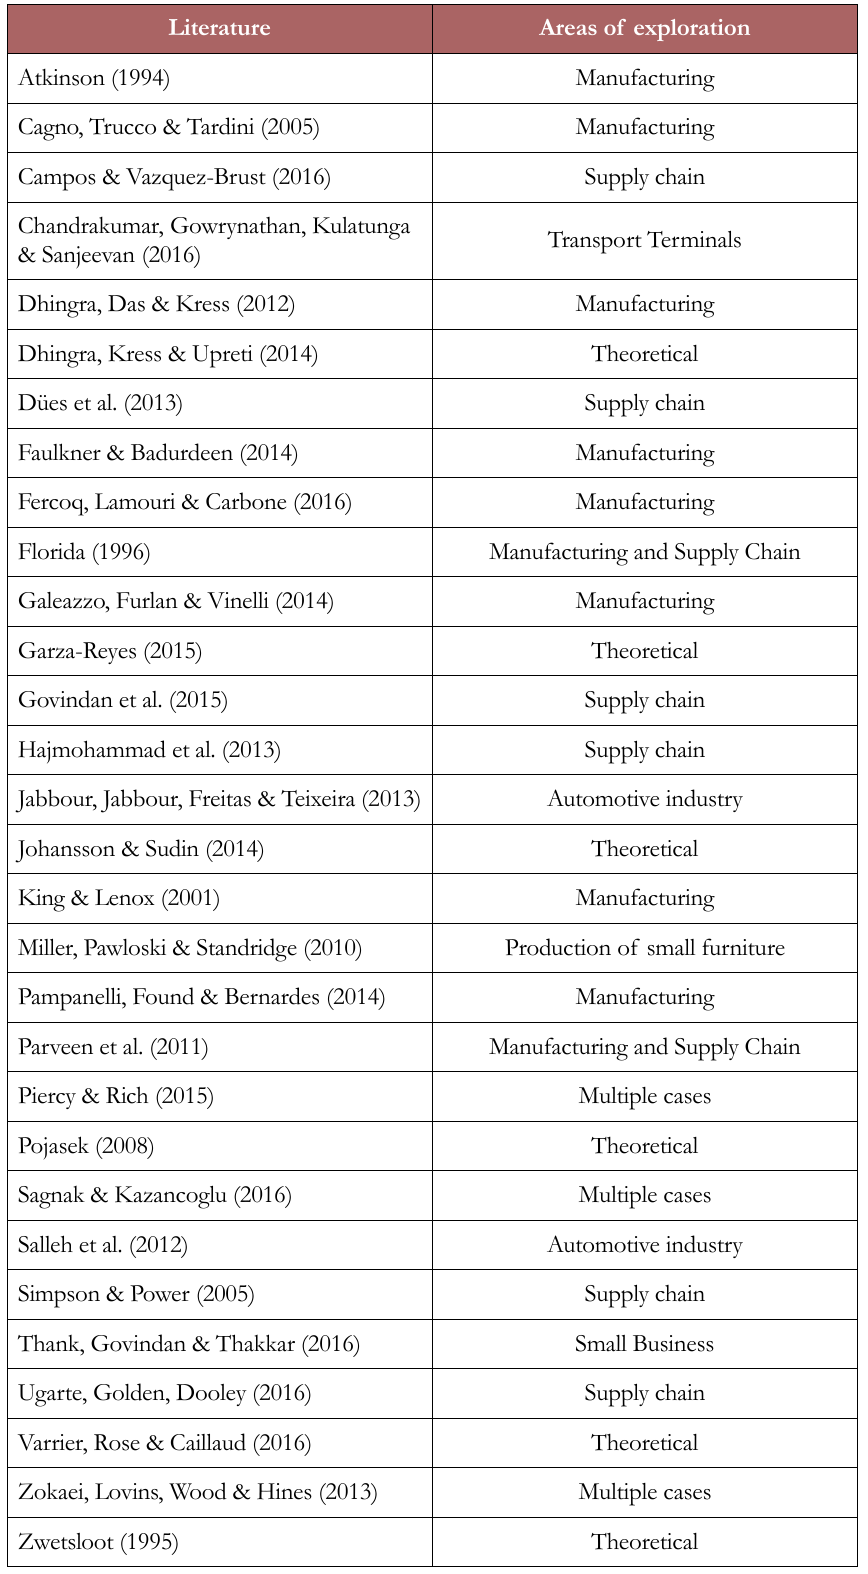
Table 1. Areas of exploitation between Lean and environmental practices in the